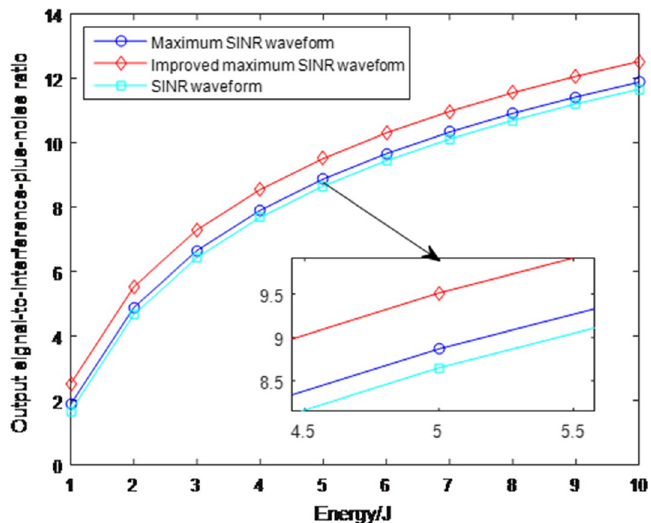
Fig. 13 Output SINR of different waveforms with minmax